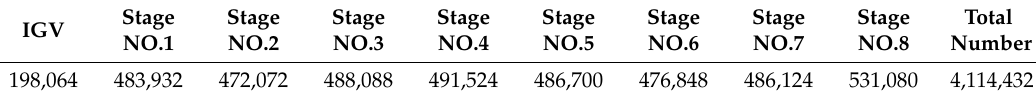
Table 1. Computational element numbers of each compressor stage.